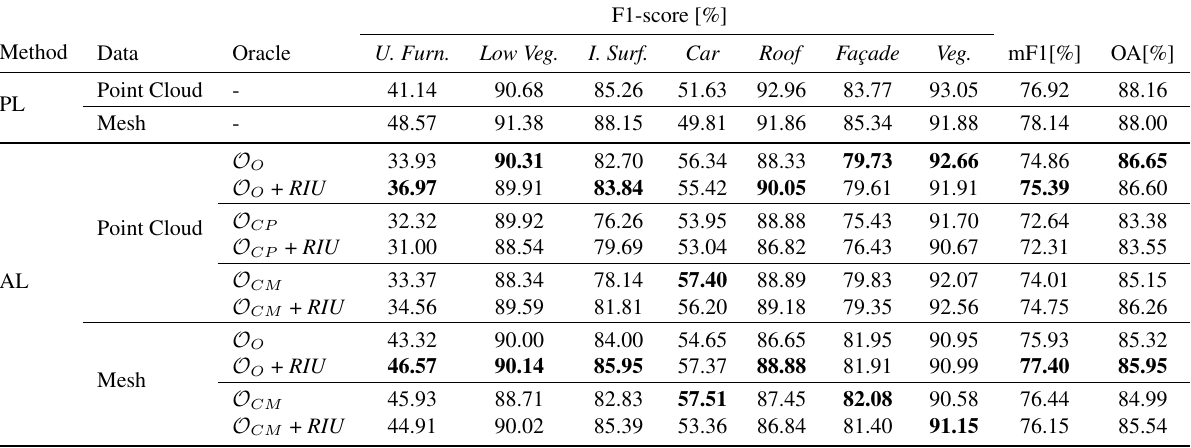
Table 1. Comparison of final classification results on the test site of H3D both for the ALS point cloud and the 3D mesh for PL and AL. The AL designations are related to our different oracle